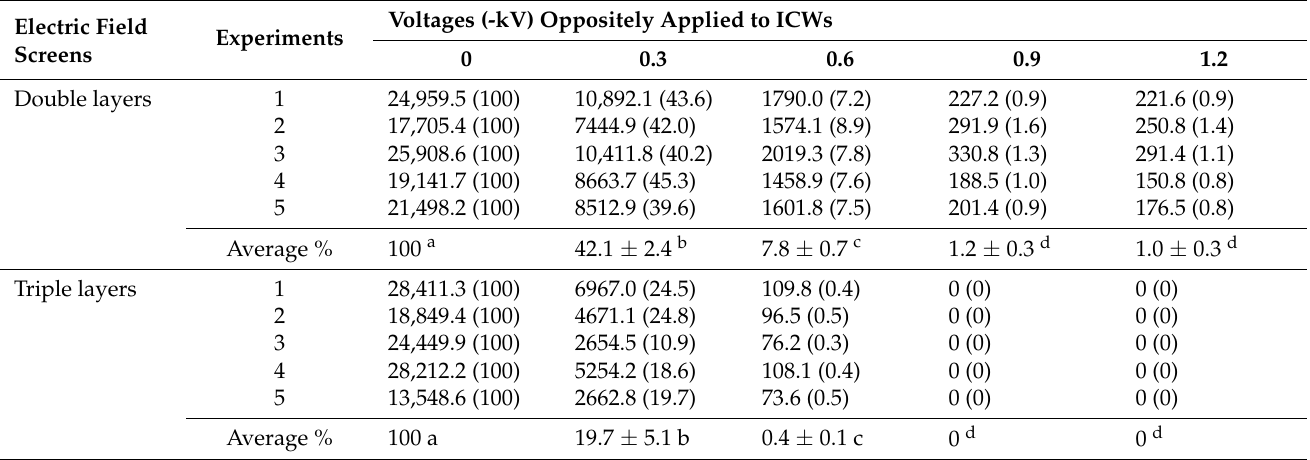
Table 1. Numbers of Penicillium digitatum spores passing through electric field screens with double or triple layers of oppositely charged insulated conductor wires